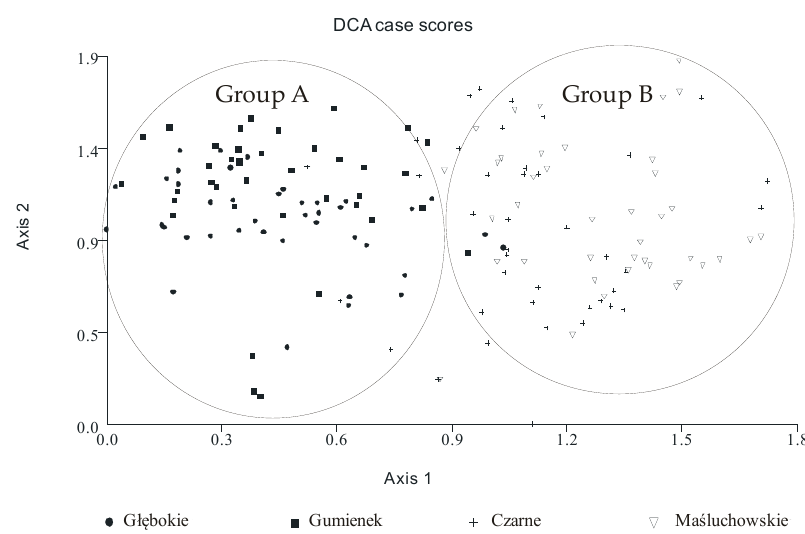
Figure 6. Detrended correspondence analysis (DCA) of the phytoplankton communities in the studied lakes during the investigation period (2010–2014).